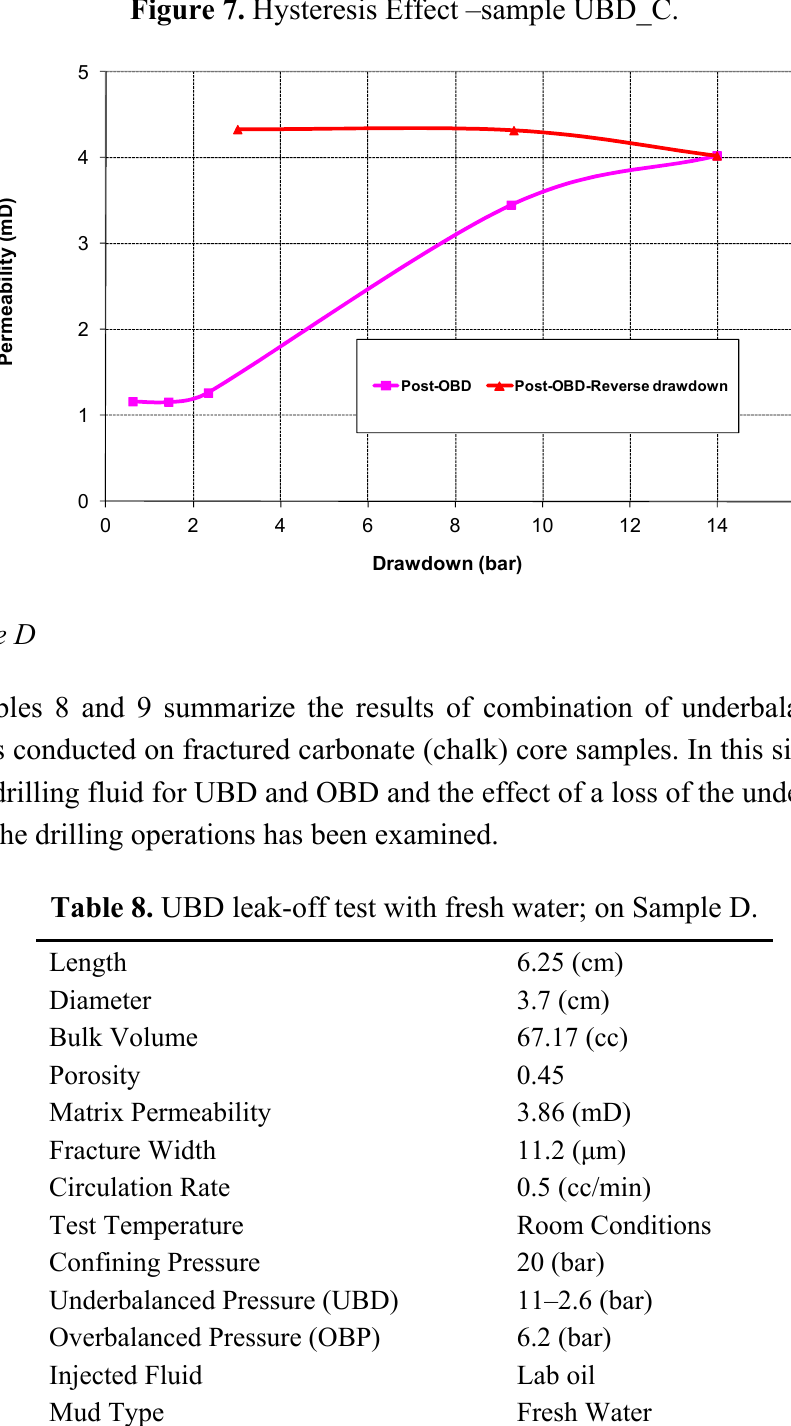
Figure 7. Hysteresis Effect –sample UBD_C.